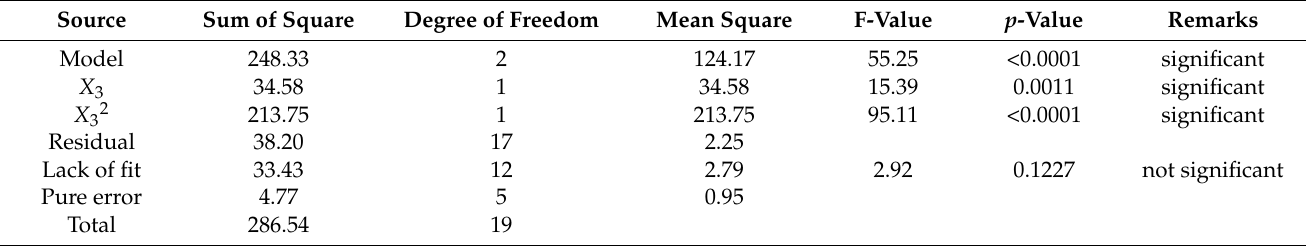
Table 3. Analysis of variance for the final predicted total anthocyanin content model.